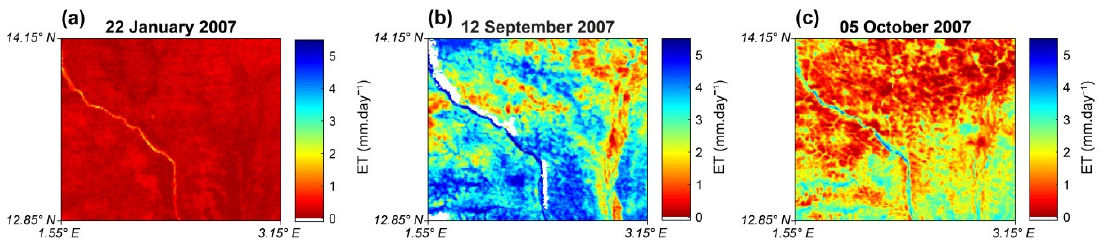
Figure 10. Examples of daily ET d maps from E3S with TERRA data ( a ) on a dry day, 22 January 2007, ( b ) a wet day, 12 September 2007, and ( c ) a transition day, 05 October 2007. White pixels mean non-available data.